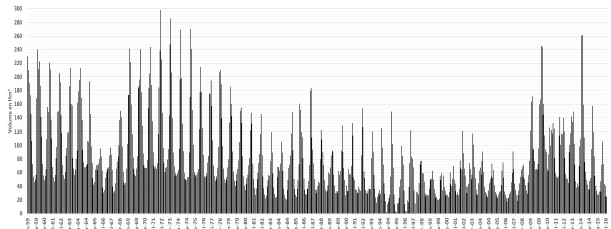
Figure 6. Volumes mensuels de la réserve régulatrice dans le bassin du Haut Sebou